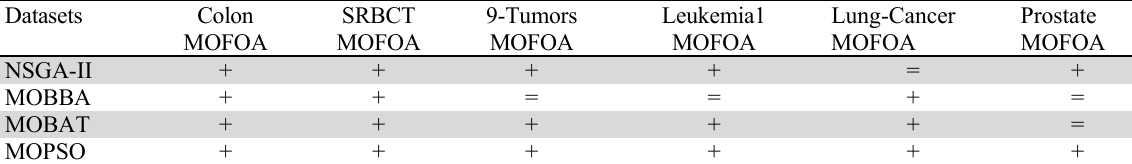
Wilcoxon rank-sum test of hypervolume ratios in the test data Datasets Colon